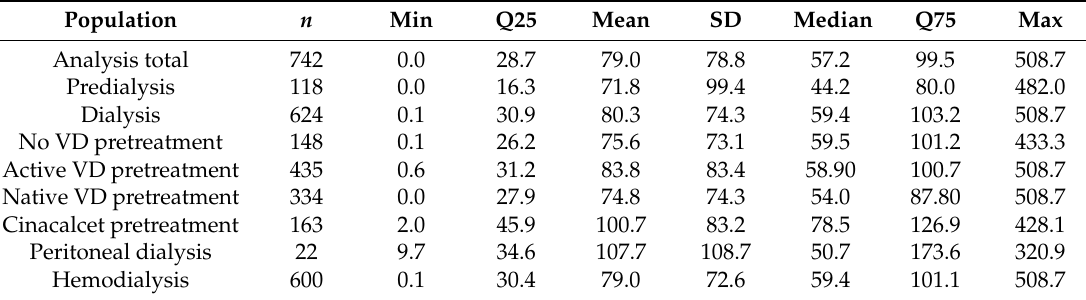
Table 7. Duration of CKD in months before study start.